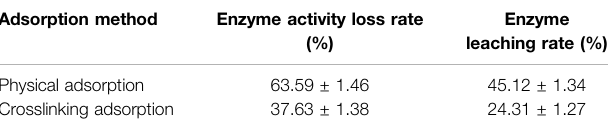
TABLE 3 | The enzyme activity loss rate and leaching rate after repeated use for seven times with different adsorption methods. Adsorption